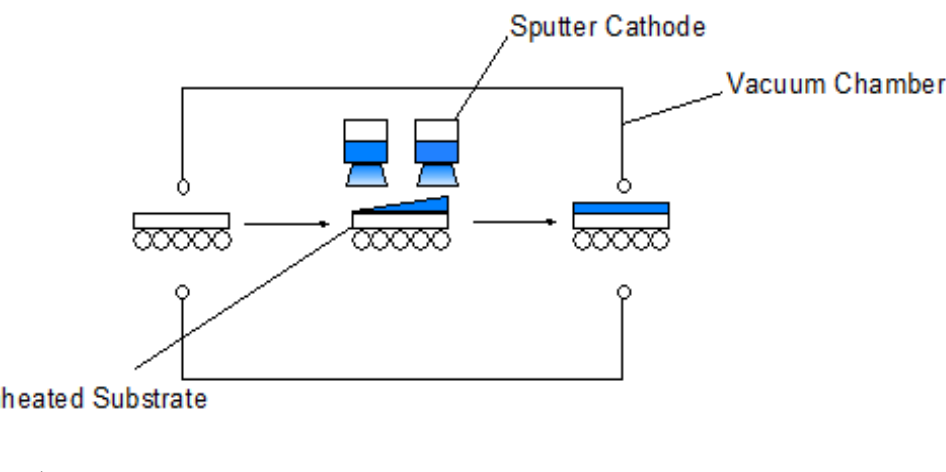
Figure 6. Schematic of the PVD process, adapted with permission from Kanu et al.